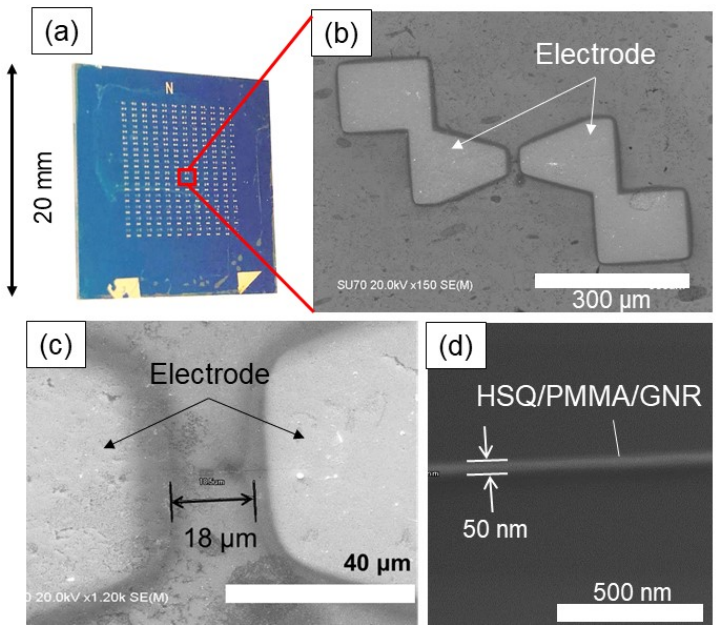
Figure 3. Observation of the -arrayed GNRs: ( a ) electrode arrangement, ( b ) SEM image of electrodes, ( c ) SEM image of gauge (GNRs), ( d ) magnified image of GNR with a width of 50 nm.